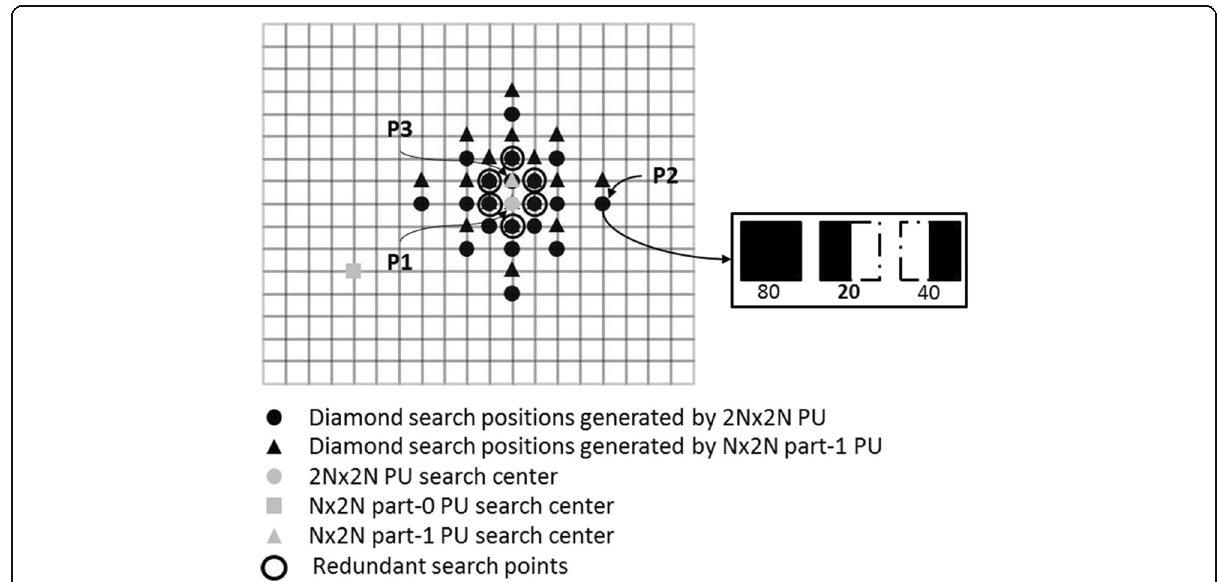
Fig. 8 The second iteration of the refinement